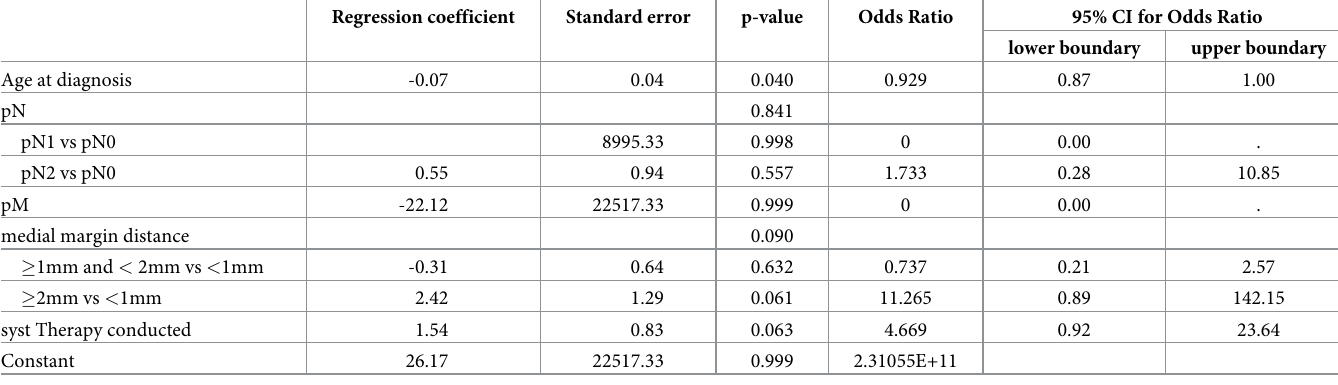
Table 5. Logistic regression model explaining the development of a recurrence during a 12 month